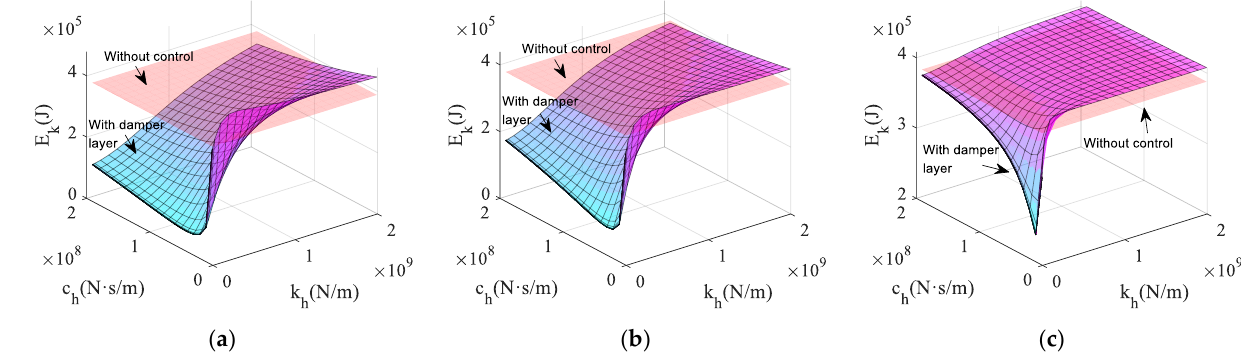
Figure 5. The mean kinetic energy versus the parameters and position of the damping layer (model 1): ( a ) the damping layer is located at the 3rd floor; ( b ) the damping layer is located at the 9th floor; ( c ) the damping layer is located at the 15th floor.